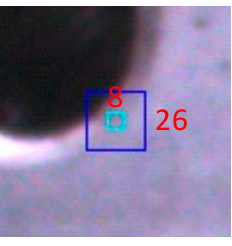
Figure 5. The relationship between convolution kernel size and neighborhood texture.